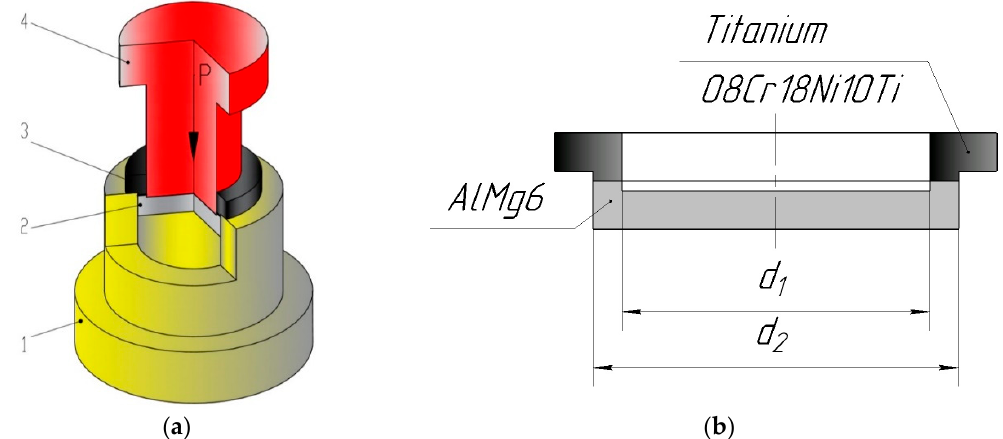
Figure 3. Tear test diagram ( a ): (1) mold, (2) AlMg6, (3) titanium / stainless steel, (4) male die; ( b ) tear strength specimen.